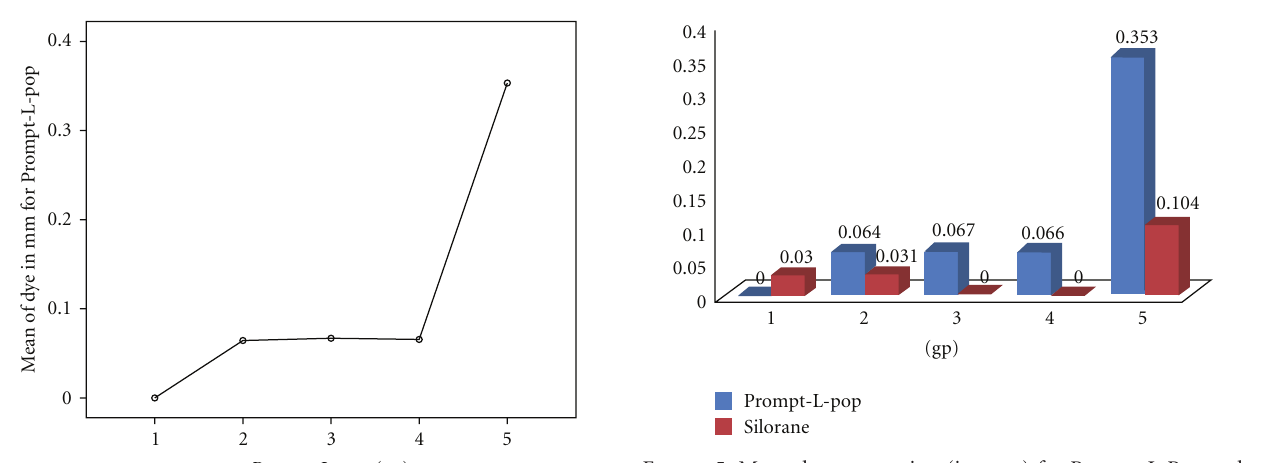
Figure 5: Mean dye penetration (in mm.) for Prompt-L-Pop and Silorane with di ff erent cavity